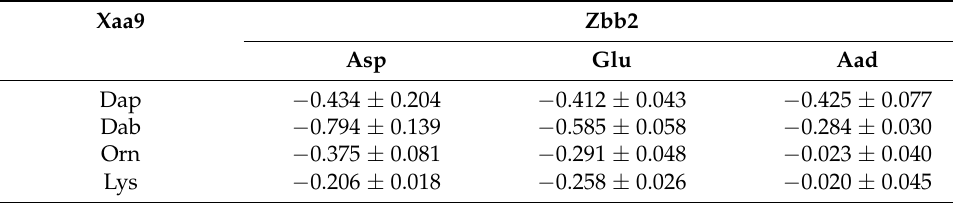
Table 5. The diagonal Zbb2-Xaa9 ion-pairing interaction energy ( ∆ G int , kcal/mol).